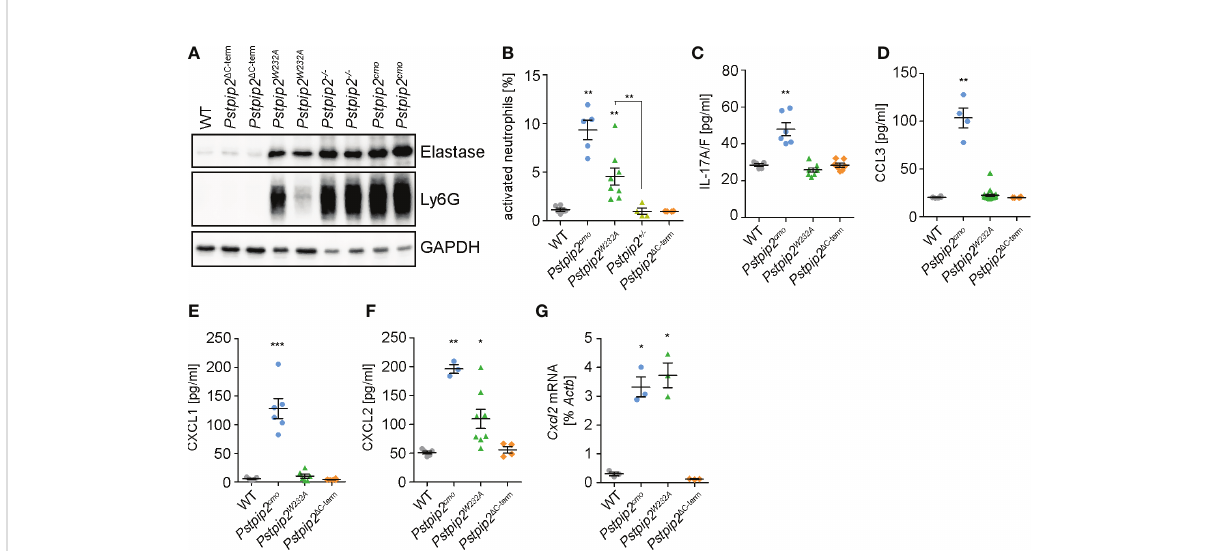
FIGURE 4 Neutrophil recruitment to the sites of in fl ammation. (A) Detection of neutrophil elastase and Ly6G in the hind paw lysates as a hallmark of neutrophil presence. (B) Percentages of activated (CD62L - ) neutrophils within total neutrophils isolated from hind paws of the mice of indicated mouse strains measured by fl ow cytometry. (C-F) Concentrations of IL-17A/F (C) , CCL3 (D) , CXCL1 (E) , and CXCL2 (F) in hind paw lysates detected by ELISA. (G) Cxcl2 mRNA levels in neutrophils puri fi ed from hind paws of the mice of indicated mouse strains determined by quantitative RT-PCR. Error bars represent mean ± SEM. Asterisks above individual columns describe p values for comparisons with WT, asterisks above connecting lines describe p values for comparisons of the columns connected by these lines; *p ≤ 0.05, **p ≤ 0.01, ***p ≤ 0.001. See Materials and Methods for further details on statistical